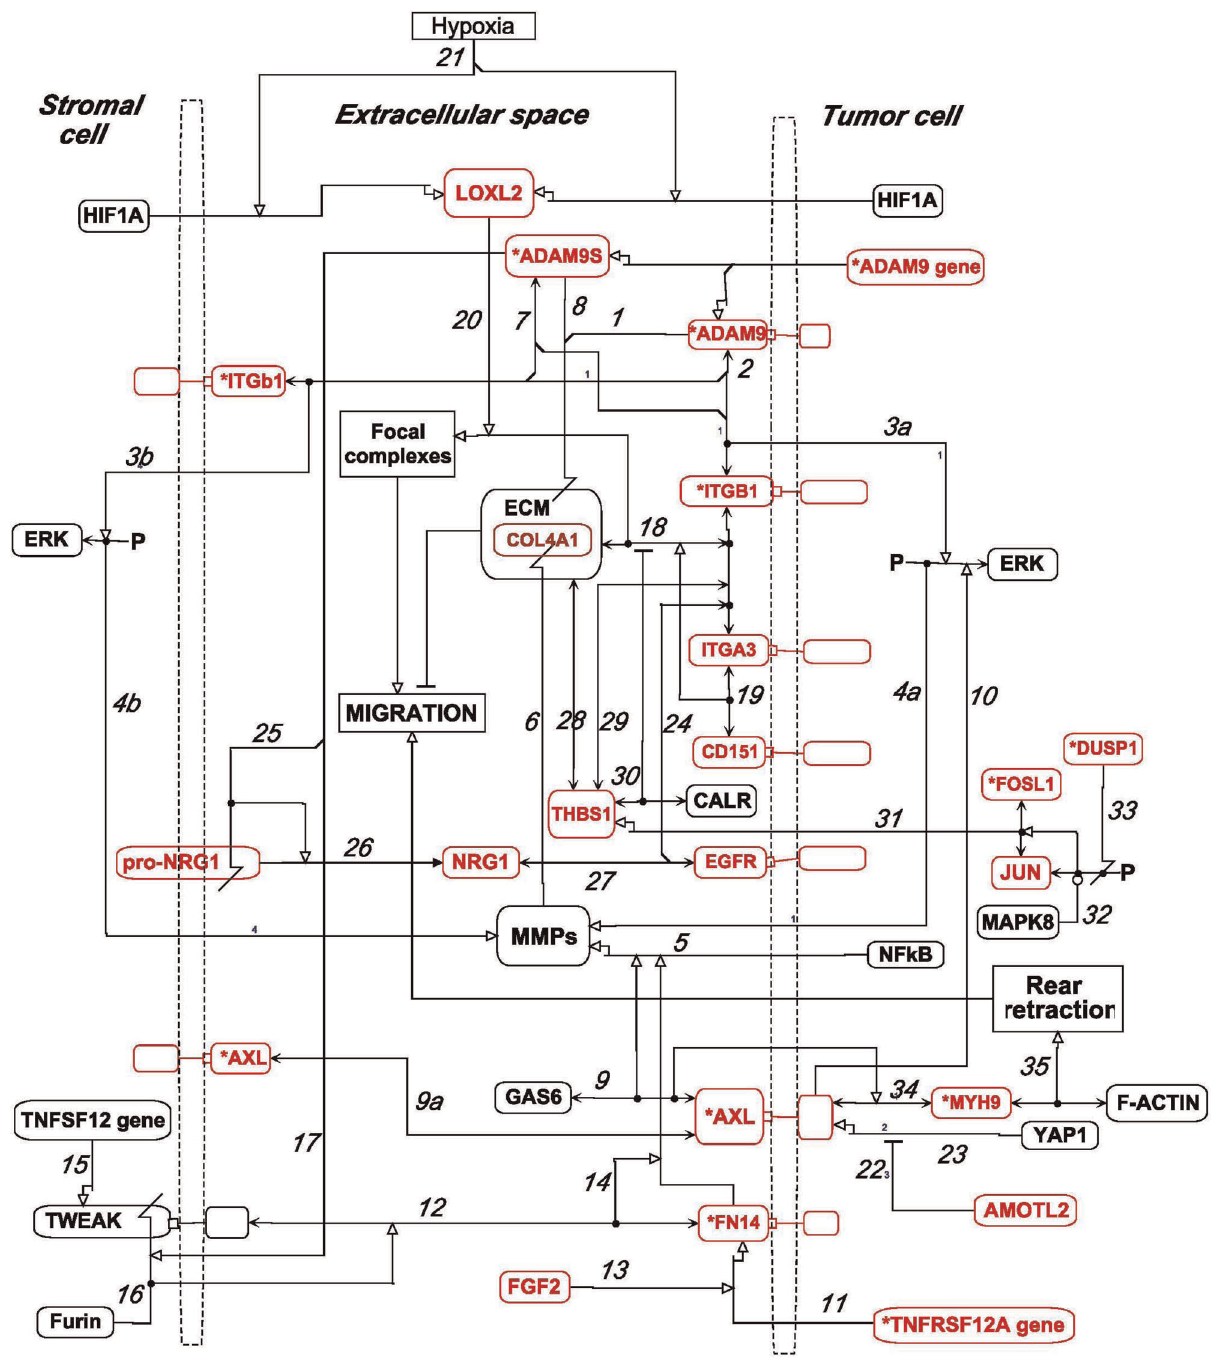
Figure 12. MIM of the role of ADAM9, AXL, ITGB1, TNFRSF12A/FN14 and functionally related genes/proteins in extracellular matrix ( ECM ) degradation or remodeling. HCCS66 genes are colored red; those that were also in the original HCCS15 set are marked with an asterisk. (MIM symbol definitions are summarized in Figure 9.)